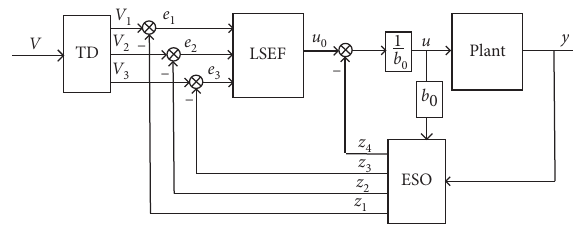
Figure 3: The schematic diagram of the